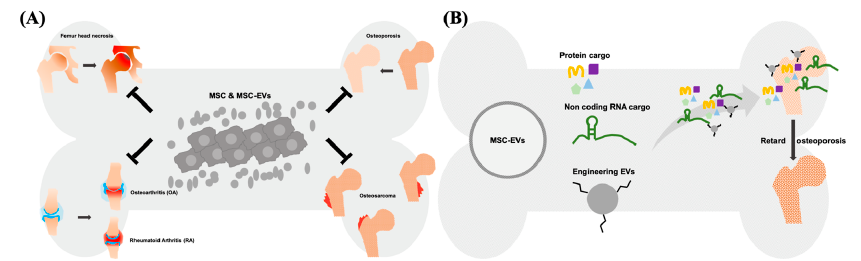
Figure 1. Application of exogenous MSC-EVs on the treatment of bone diseases. ( A ) MSCs and their secreted EVs have been used to successfully treat the femur head necrosis, OA, RA, osteosarcoma, and osteoporosis. ( B ) The retardation of osteoporosis by exogenous MSC-EVs might attribute to carried cargo (protein and non-coding RNA), or exerted by engineering